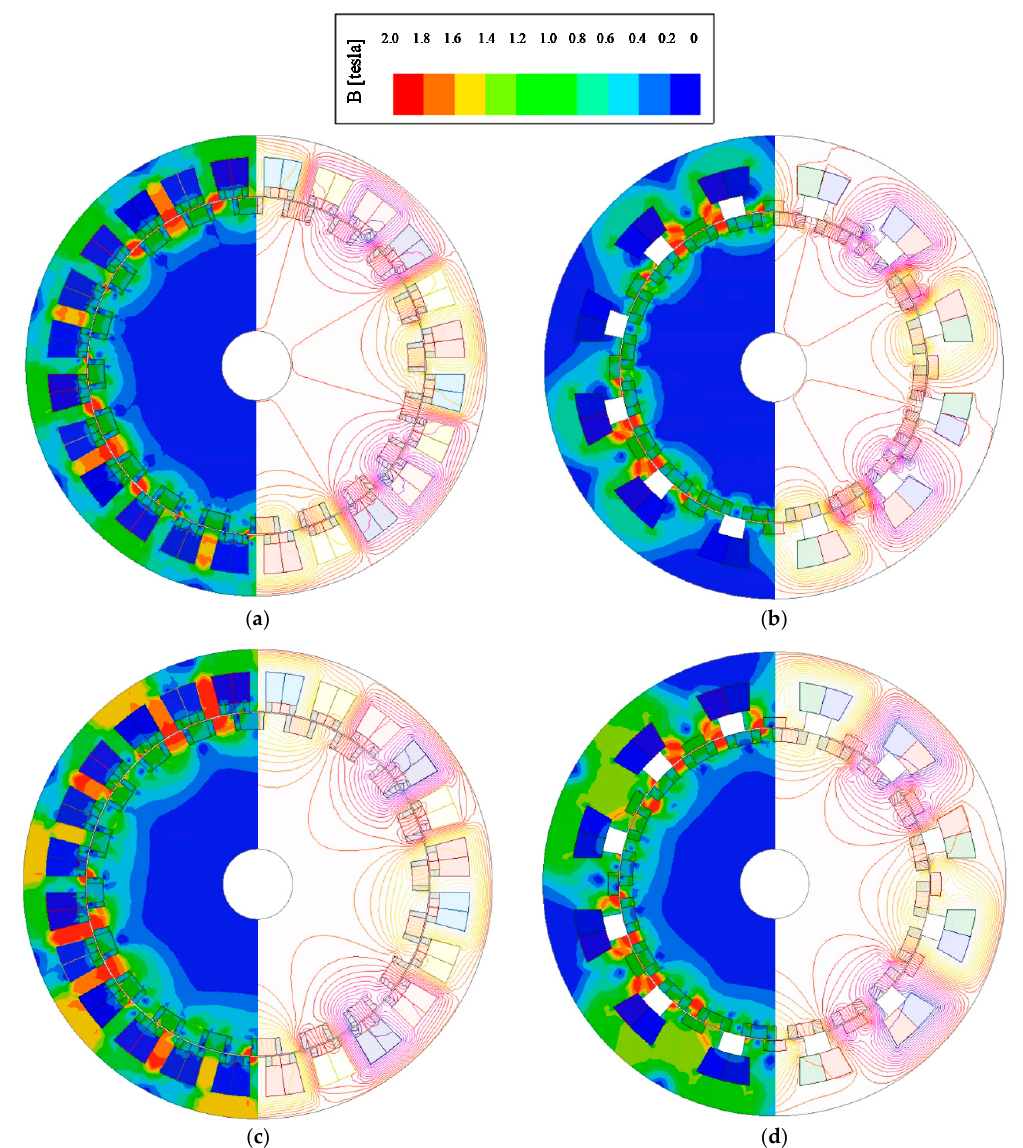
Figure 19. Flux density distributions of two dual-PM machines. ( a ) 24S20R4Pa SSDPM machine at open circuit condition; ( b ) 12S20R4Pa STDPM machine at open circuit condition; ( c ) 24S20R4Pa SSDPM machine at load condition ( I d = 0 and I q = I max ); ( d ) 12S20R4Pa STDPM machine at load condition ( I d = 0 and I q = I max ).